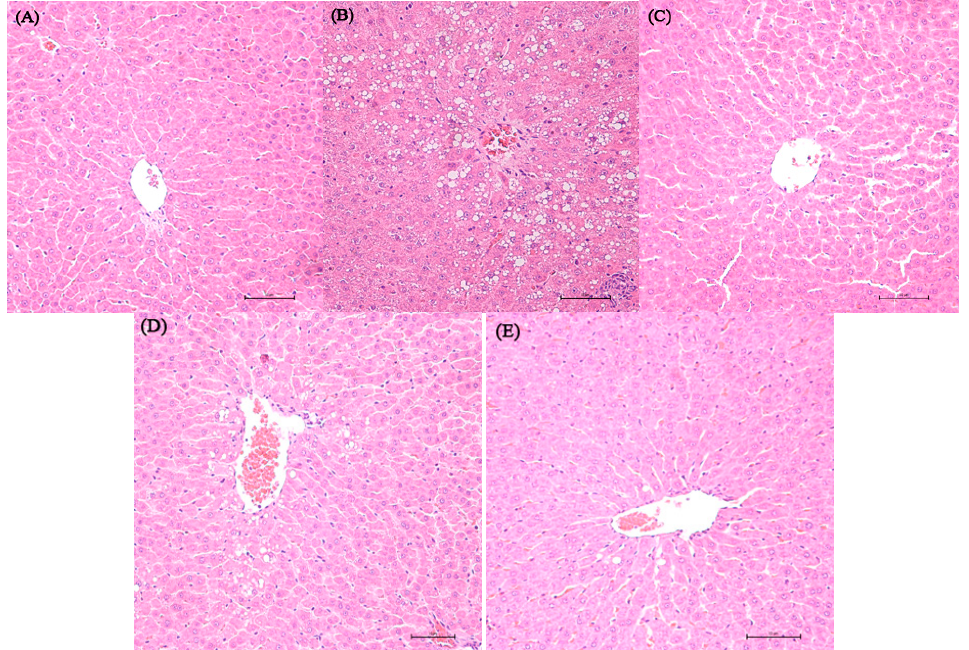
Figure 1. Effect of nucleotides (NTs) on liver histology in rats. Representative photomicrographs with H & E staining reveal histopathological changes of liver from normal control rats, dextrose control rats and alcohol control rats with or without nucleotides treatment (400×). ( A ) Normal control group; ( B ) Alcohol control group; ( C ) Dextrose control group; ( D ) 0.04% NTs group; ( E ) 0.16% NTs group.